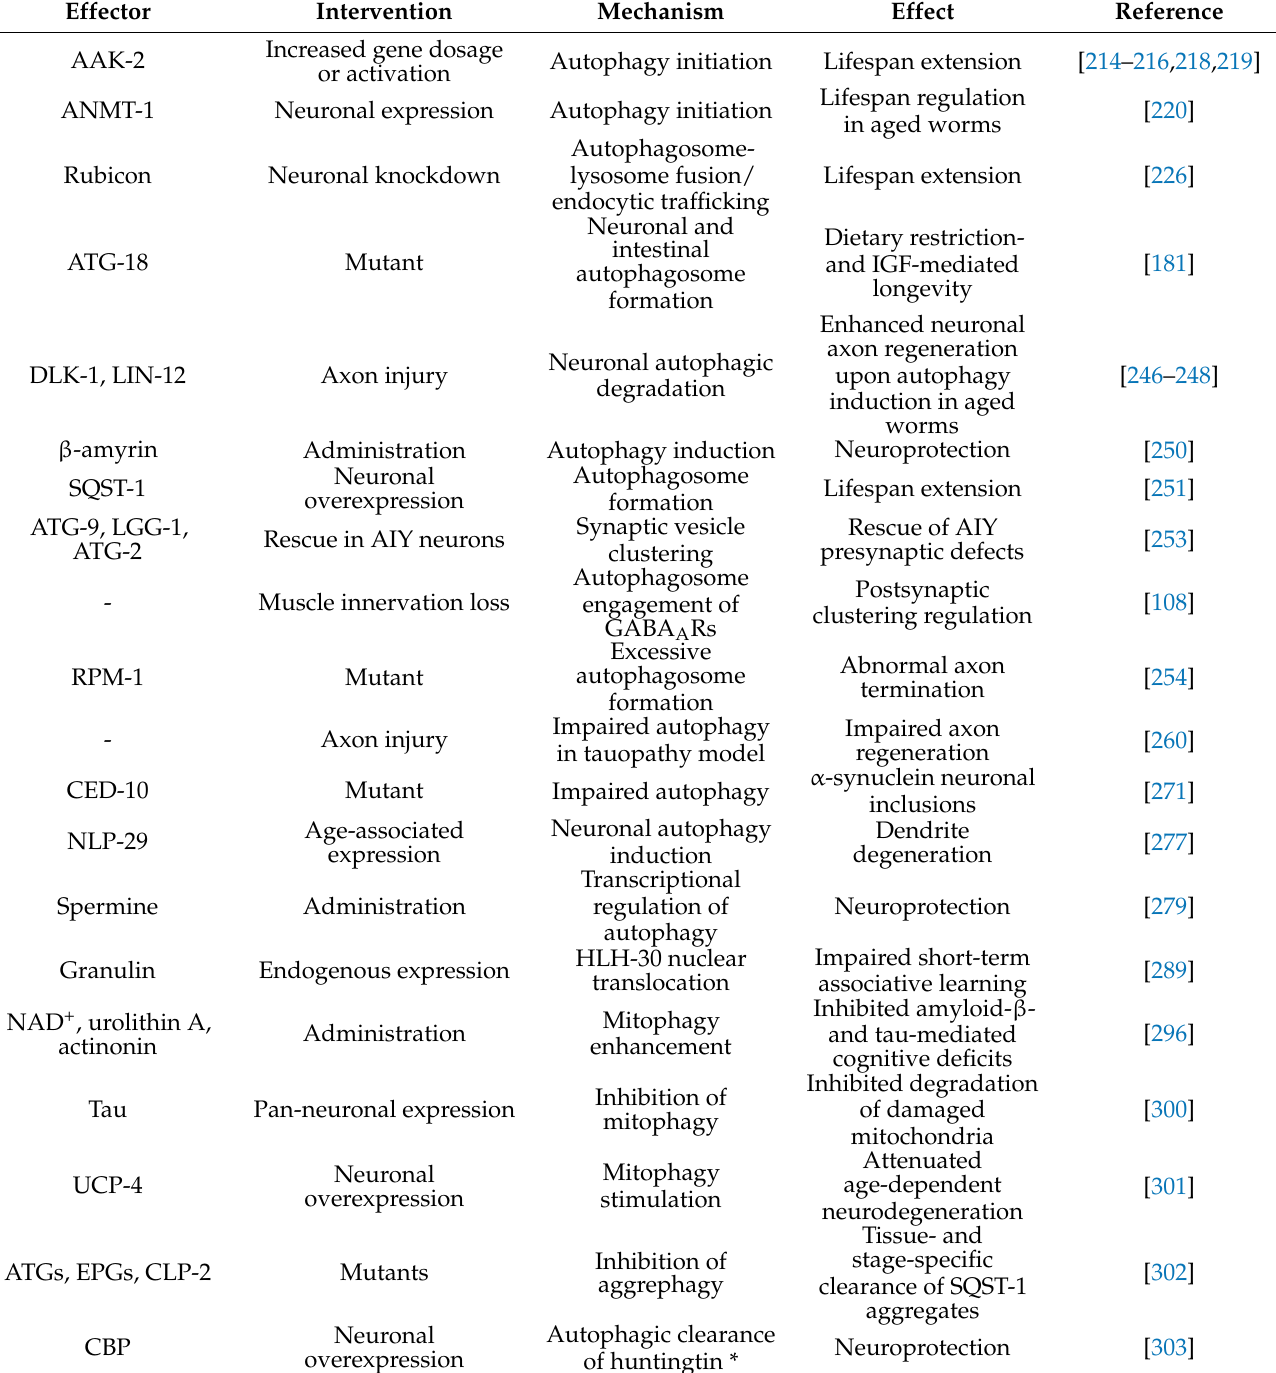
Table 2. Regulation of ageing by neuronal autophagy in Caenorhabditis elegans .